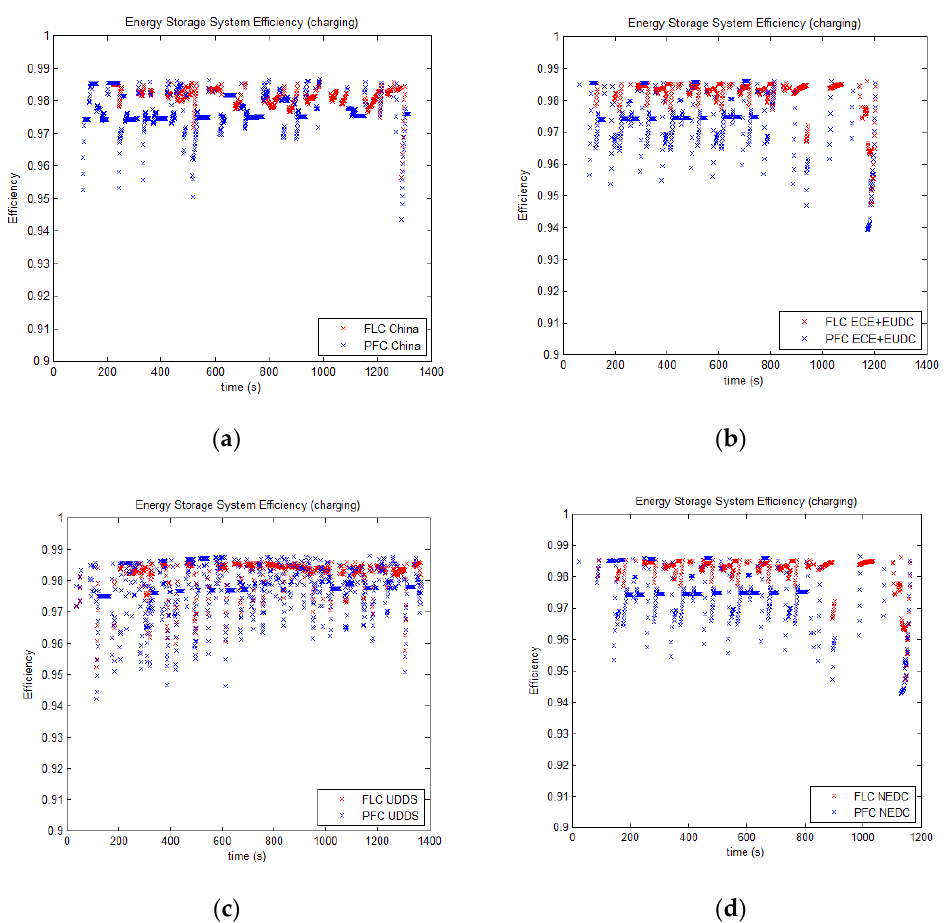
Figure 5. Energy storage system efficiency of charging: ( a ) China, ( b ) ECE+EUDC, ( c ) UDDS, and ( d ) NEDC.